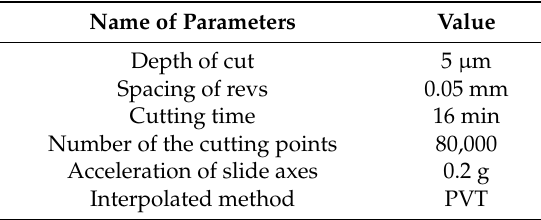
Table 3. Machining parameters in manufacturing the compound surface.